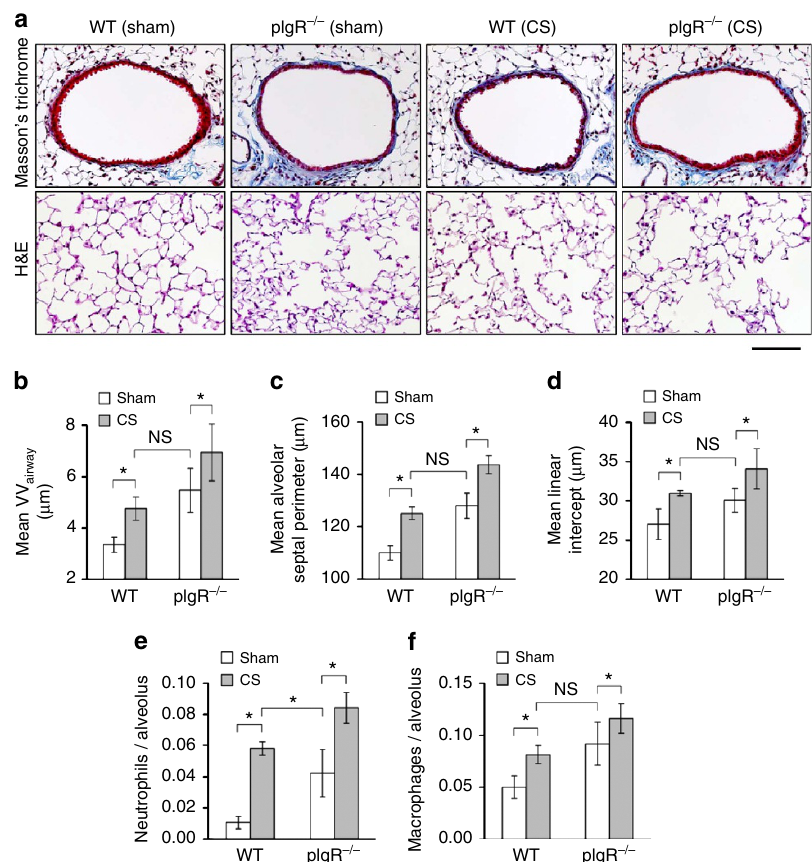
Figure 7 | CS treatment increases airway remodelling and emphysema in pIgR (cid:2) / (cid:2) mice. ( a ) Representative images of small airway remodelling (Masson’s trichrome, original magnification, (cid:3) 200X and emphysema (haematoxylin and eosin (H&E), original magnification, (cid:3) 200) in WTand pIgR (cid:2) / (cid:2) mice treated twice daily with mainstream CS or sham control (filtered air) for 6 months (between 2 and 8 months of age). Scale bar, 50 m m. ( b – d ) Morphometric analysis of small airway wall thickness (VV airway ), mean alveolar septal perimeter length and mean linear intercept length. Fve mice per group; * P o 0.01 compared with WT mice treated with sham; ** P o 0.01 compared with all other groups (two-way analysis of variance (ANOVA)). ( e , f ) Parenchymal neutrophil and macrophage counts in lung tissue from WTor pIgR (cid:2) / (cid:2) mice. Five mice per group; * P o 0.01 compared with WT mice treated with sham; ** P o 0.01 compared with all other groups (two-way